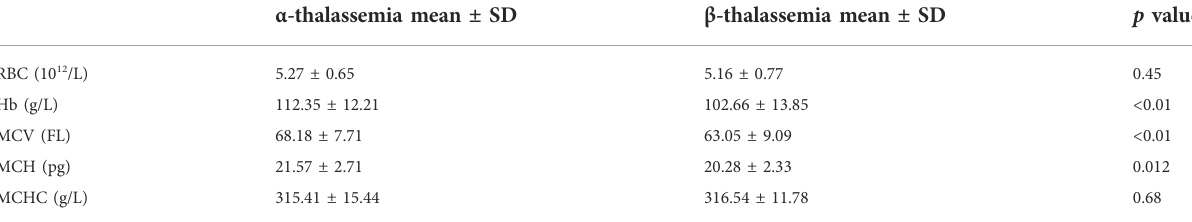
TABLE 2 The differences of hematological parameters between α -thalassemia and β -thalassemia.